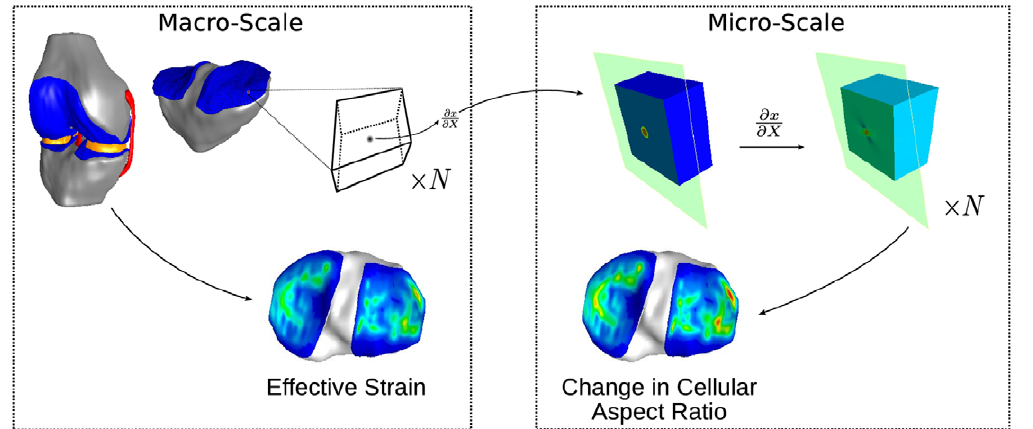
Figure 1. The autonomous approach to couple joint, tissue, and cell scales is shown above. Left: The method began with the FEA of a macro-scale model for a kinetic/kinematic scenario. Deformation gradients at the centroids of finite elements in tissue regions of interest were calculated from element nodal positions. Right: Displacement boundary conditions were prescribed to surface nodes of independent micro-scale models corresponding to the deformation gradient of each finite element experiencing deformation in tissue regions considered. Results of micro- scale FEA solutions were post-processed to calculate deformation metrics of interest.